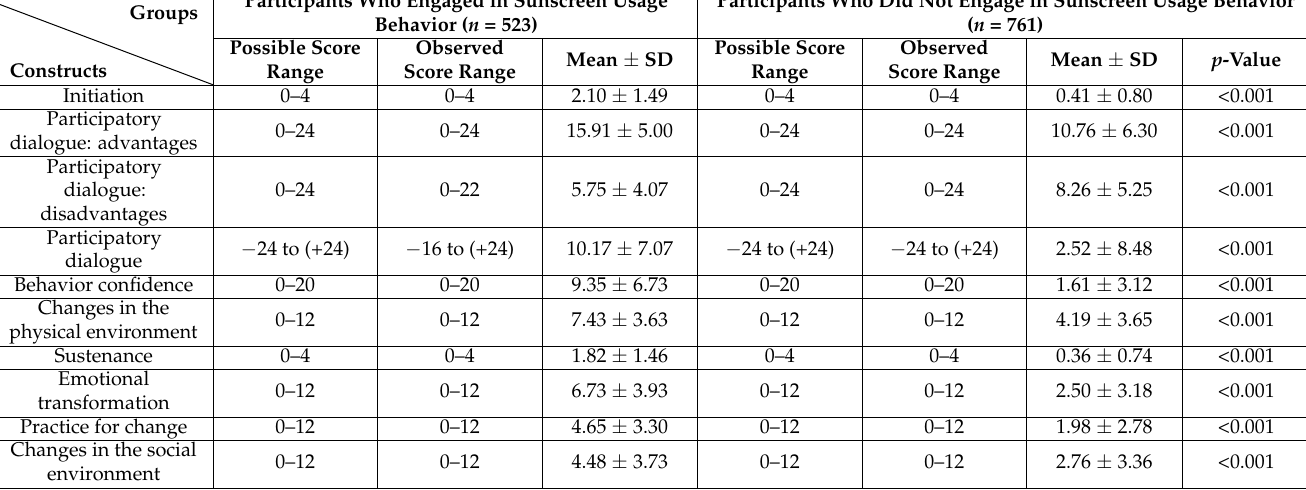
Table 2. Possible and observed range and mean scores of multi-theory model constructs of behavior change across participants who engaged in sunscreen usage behavior and those who did not engage in sunscreen usage behavior ( n = 1284).